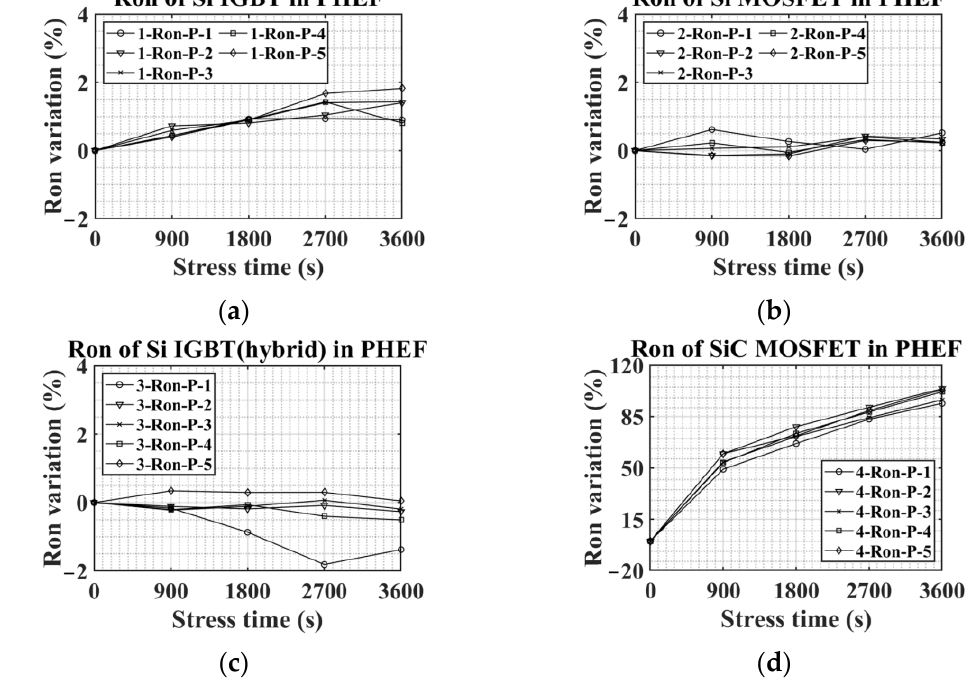
Figure 9. R on variations in PHEF stress: ( a ) Si IGBT, ( b ) Si MOSFET, ( c ) Si IGBT with SiC diode, and ( d ) SiC MOSFET.